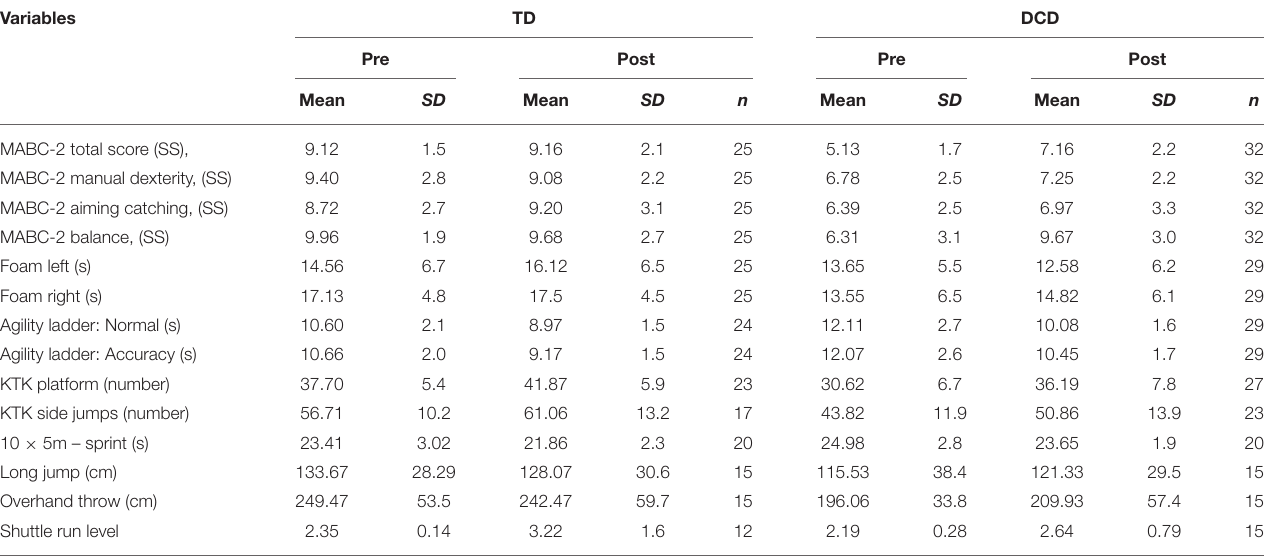
TABLE 4 | Means and standard deviations of motor and fitness performance variables before and after training for the TD and DCD groups for the children who have participated in the post-test.